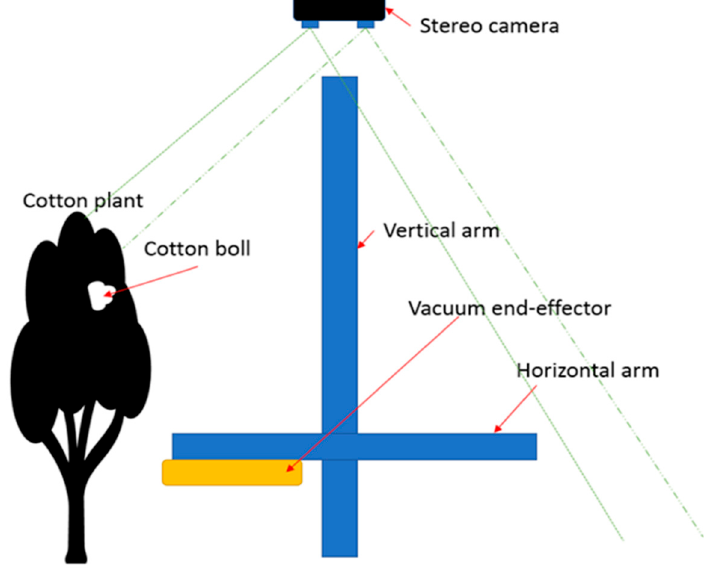
Figure 6. Robotic Cartesian arm contextual diagram.